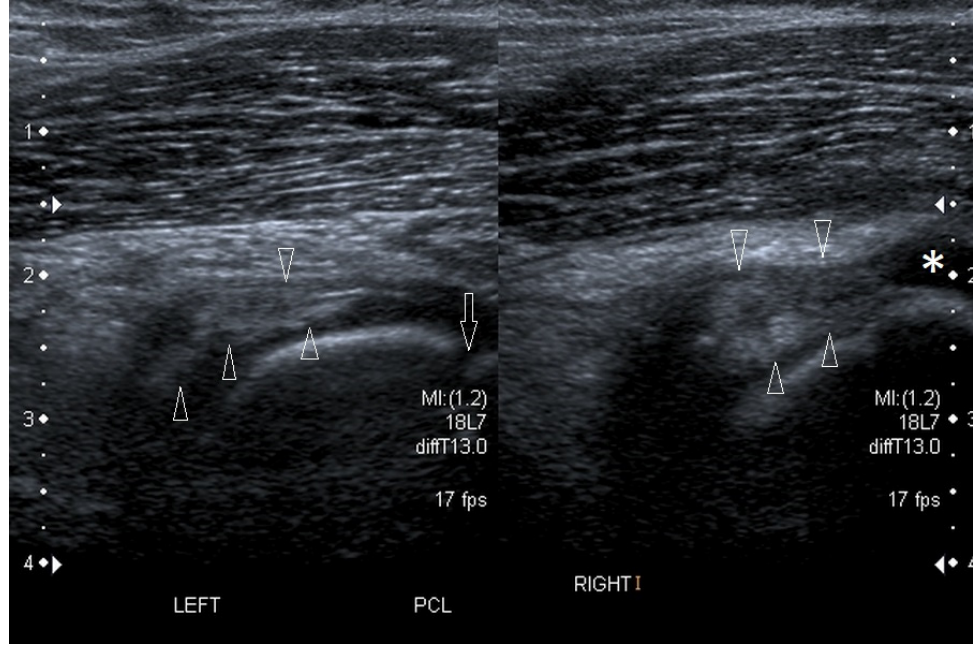
Figure 10. A case of posterior cruciate ligament (PCL) injury in a 15-year-old boy. Longitudinal scans through the middle part of the popliteal fossa. On the left—the image of healthy, undamaged PCL (arrowheads) in the left knee joint, the arrow indicates the level of growth plate. On the right—completely damaged, shrunken in the peripheral direction and doubled PCL (arrowheads); asterisk—fluid posterior to the proximal epiphysis of the tibia. Linear probe 7–18 MHz.